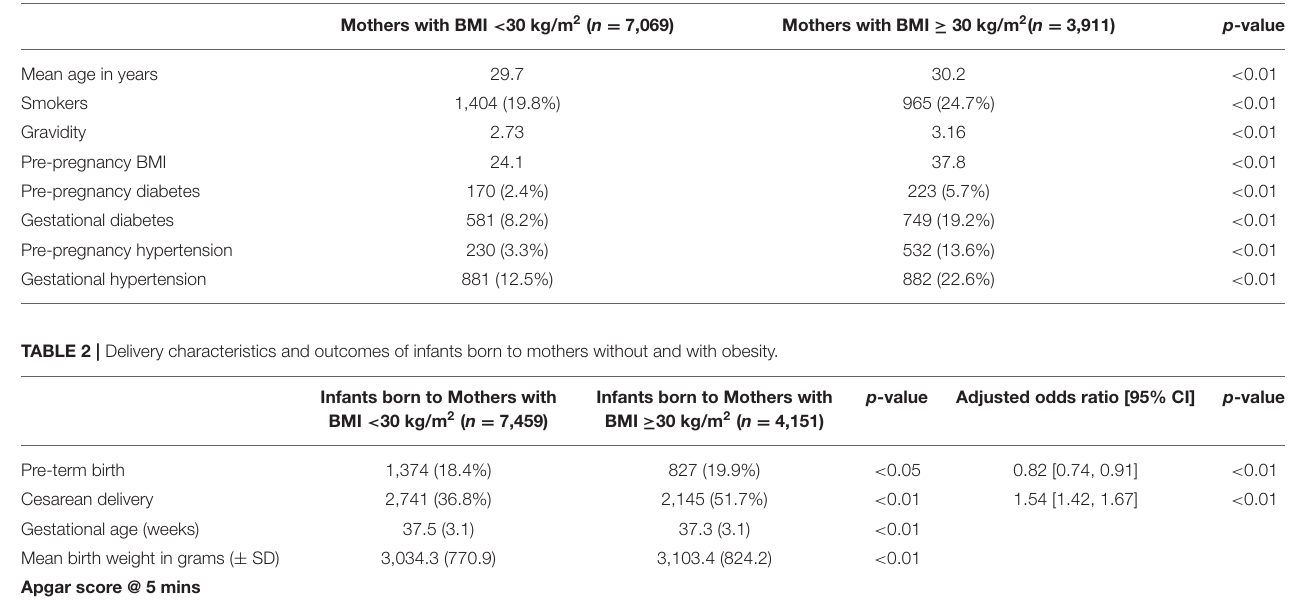
TABLE 1 | Characteristics of mothers without and with obesity.